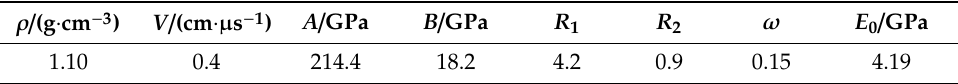
Table 6. Detonation product state equation related parameters.